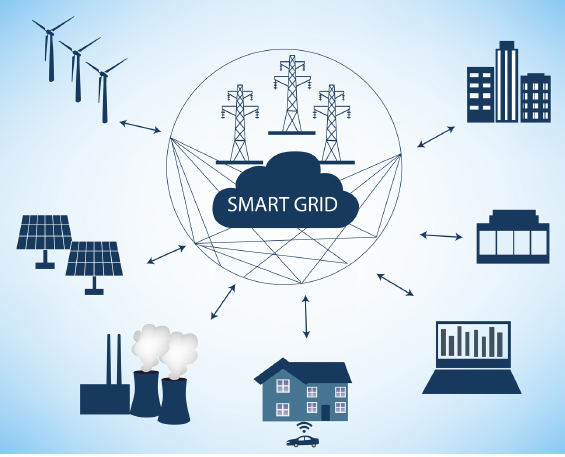
Figure 1. Smart grid